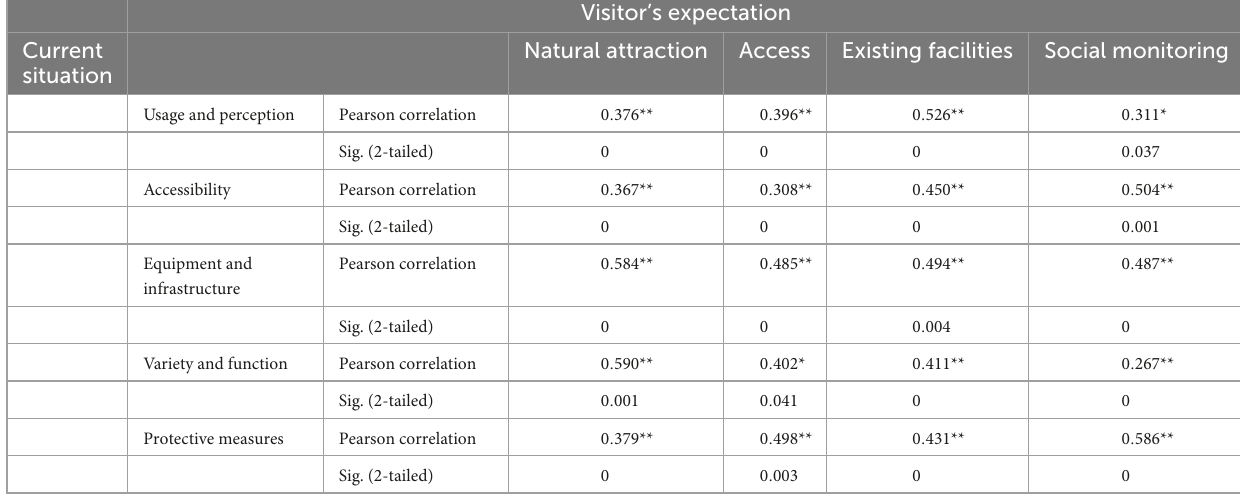
TABLE 5 B-variety correlation between visitors’ expectations and the current situation.